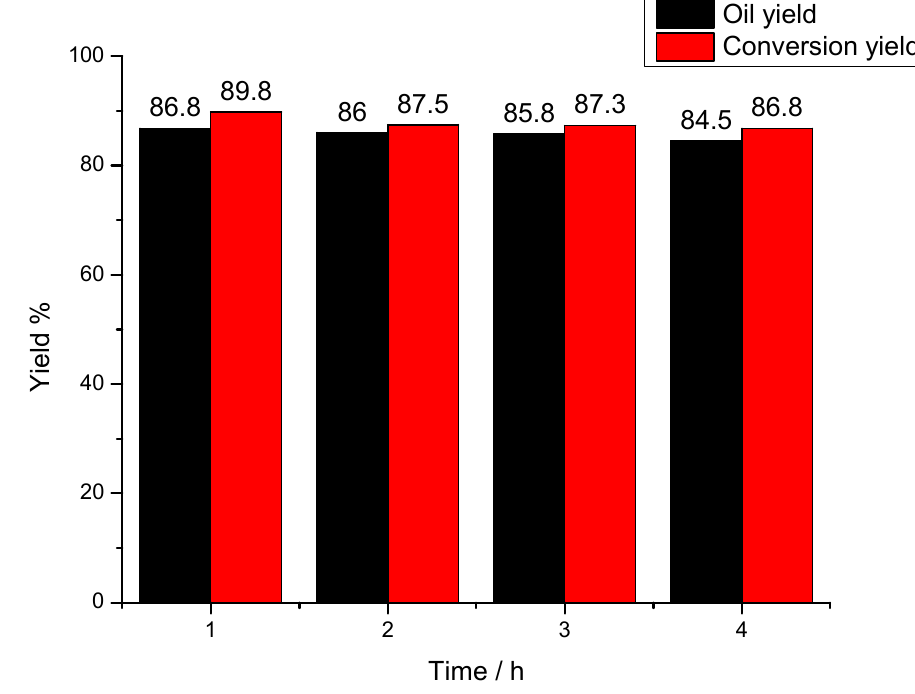
Figure 2. Effect of reaction time on lignin conversion. Reaction conditions: reaction temperature was 160 °C, solvent ratio of methanol to glycerol was 2:1, catalyst dosage was 5.0 wt %.